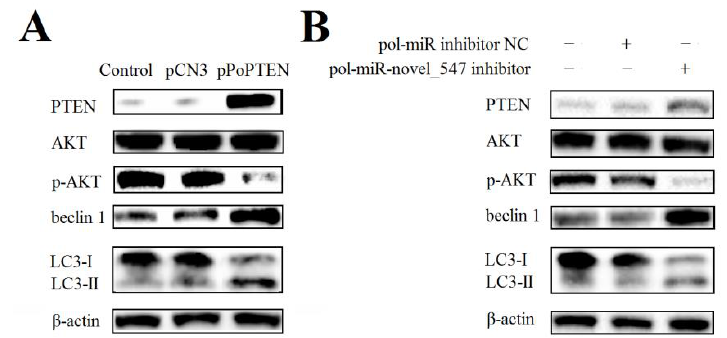
Figure 7. Effects of PoPTEN and pol-miR-novel_547 on the expression of autophagy-related genes in mammalian and fish cells. ( A ) HEK293T cells were transfected with or without (control) pPoPTEN or pCN3 for 24 h. ( B ) FG-9307 cells were transfected with or without (control) pol-miR-novel_547 inhibitor or pol-miR-NC inhibitor for 24 h. For both panels, PTEN, AKT, p-AKT (phosphorylated AKT), beclin 1, and LC3 proteins were detected by Western blot. β-actin was used as a loading control.